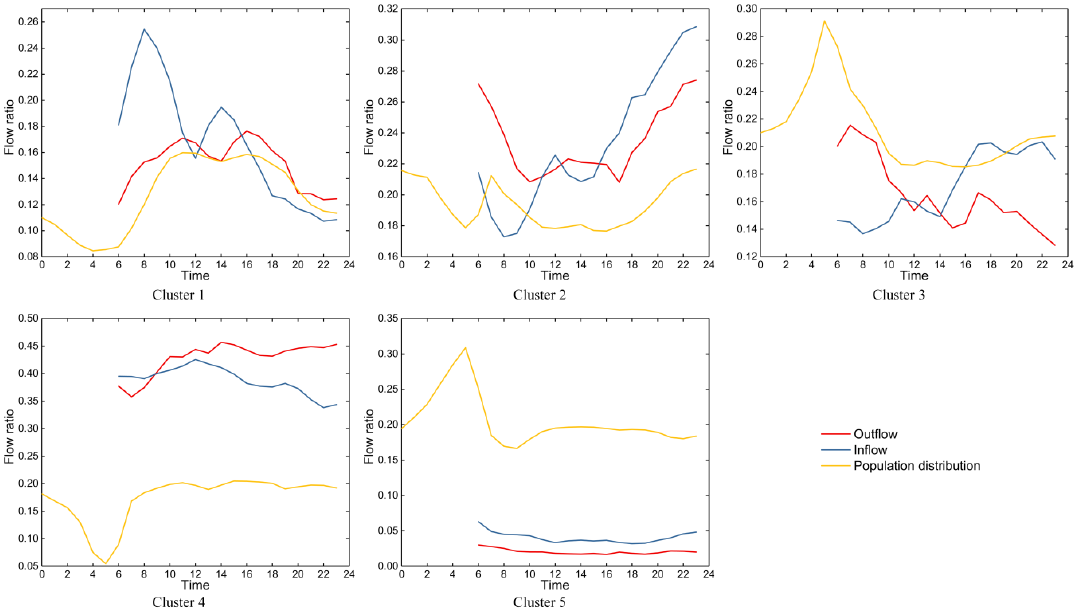
Figure 4. The temporal variation characteristics of the population inflow/outflow and population density in different building function clusters.